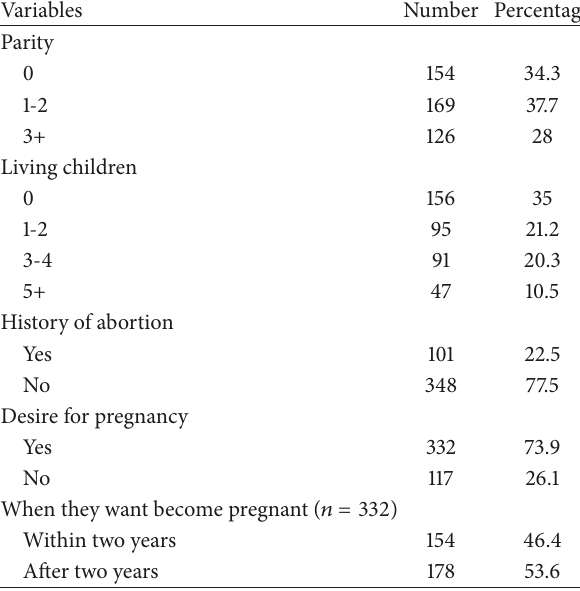
Table 2: Obstetrics characteristics of Implanon user women in Debre Tabor town public health facilities, northwest Ethiopia, August 2016 ( 𝑛 = 449